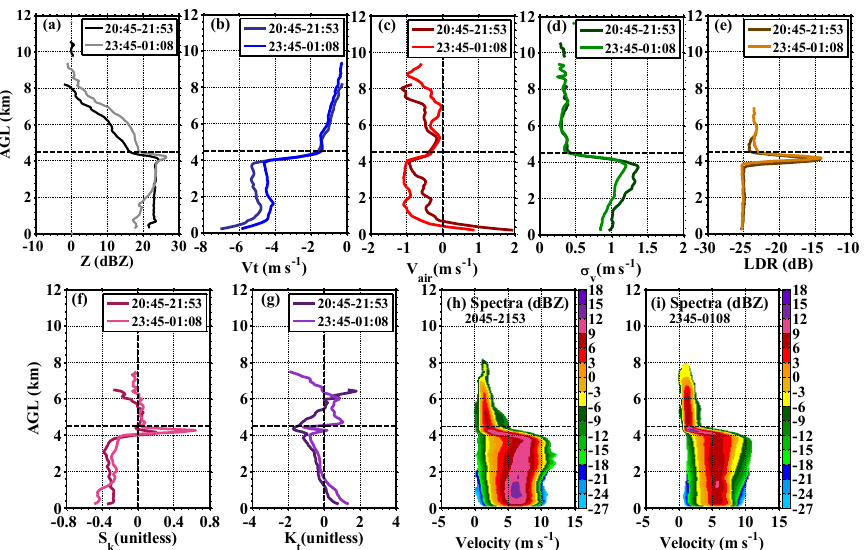
Figure 10. Time–height cross-sections of the MMCR measurements and the ground rain rate and DSD for a period of CSMCs obtained from 20:00 BJT on 22 April to 02:00 BJT on 23 April. ( a )–( i ) are radar reflectivity, particle terminal velocity, vertical air velocity, spectrum width, linear depolarization ratio, spectral skewness, and spectral kurtosis; ( h ) and ( i ) are ground rain rate and drop size distribution.